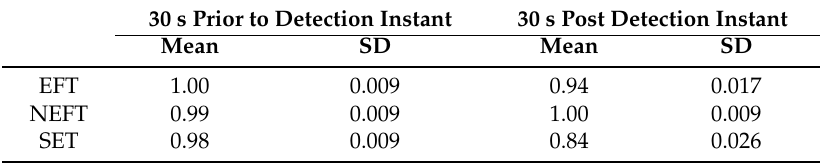
Table 2. Micro-UAV sensor response statistics before and after the detection